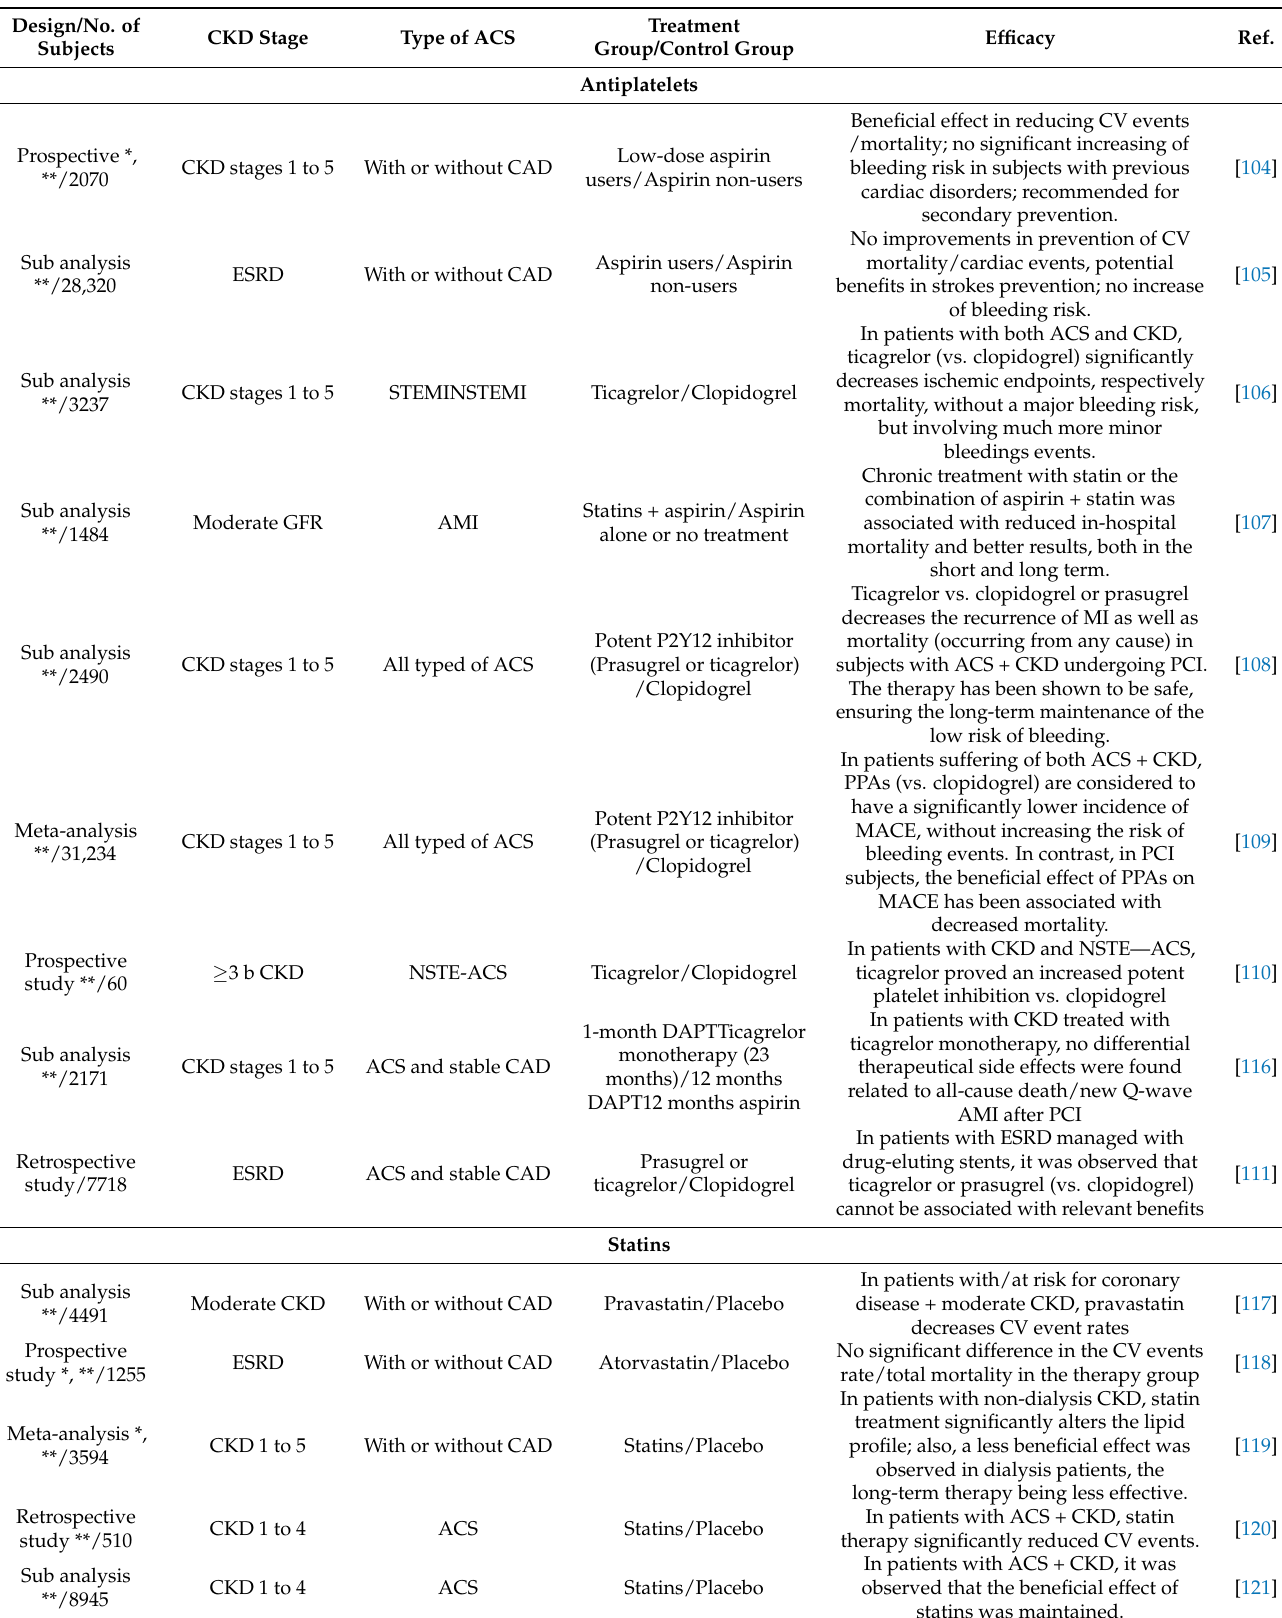
Table 2. Relevant findings regarding treatment options in ACS and associated